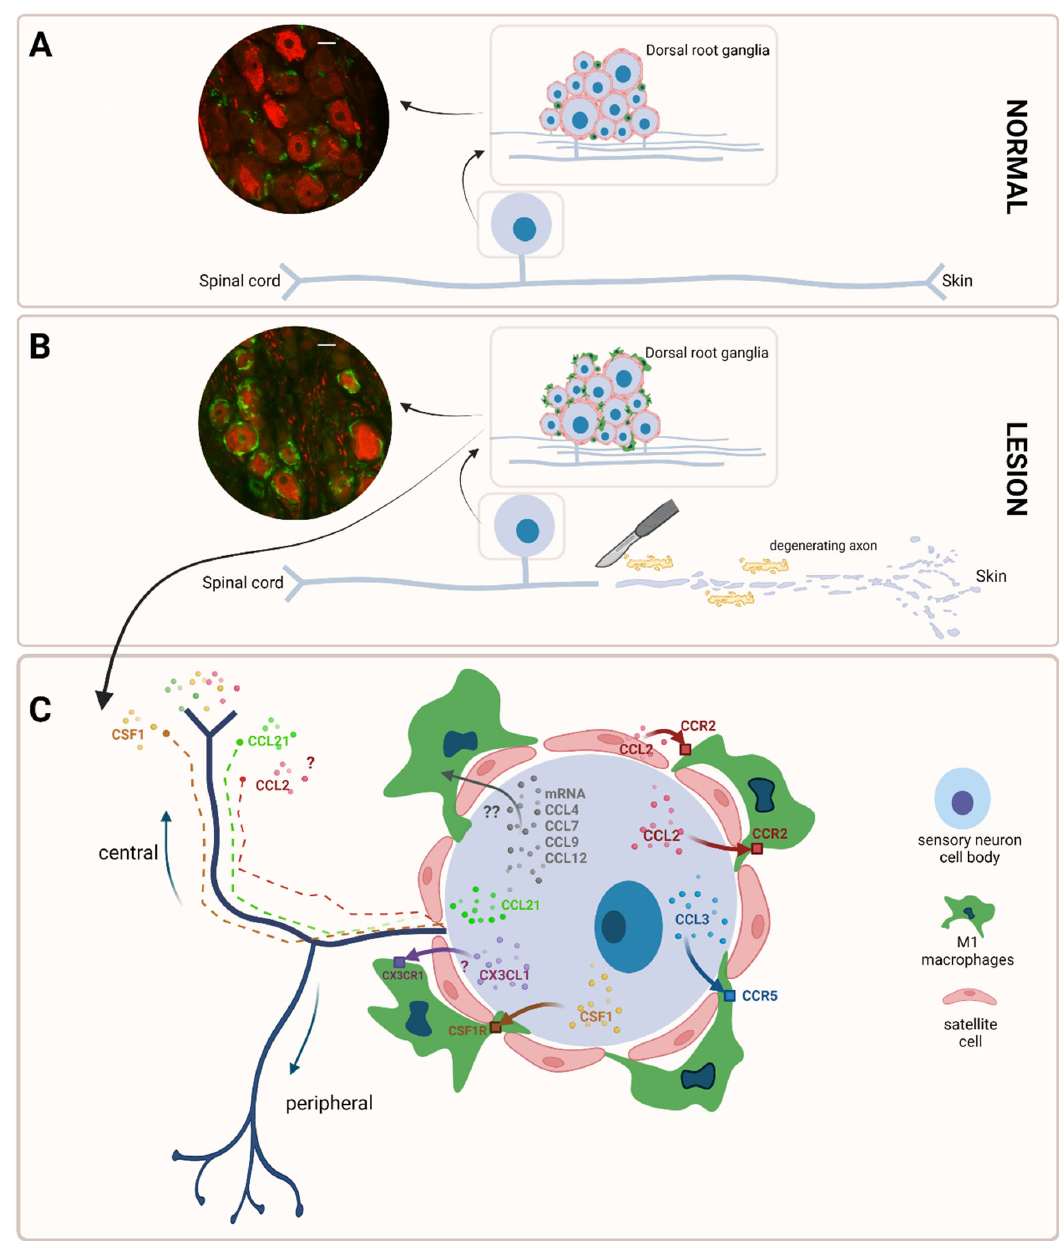
Figure 3. After a peripheral nerve lesion, macrophages are attracted around the DRG neurons. ( A ) Graphic representation of a normal DRG, with few macrophages scattered between DRG neurons. To the left, DRG immunostaining showing a small number of Iba1 (+) macrophages (green) scattered among large NF200 (+) neurons (red). Scale bar—20 μ m. ( B ) Graphic representation of the DRG after the peripheral nerve lesion, with numerous endoneurial and hematogenous macrophages attracted around neurons. To the left, DRG immunostaining showing an increased number of Iba1 (+) macrophages (green) around large NF200 (+) neurons (red). Scale bar—20 μ m. ( C ) Signaling pathways that attract macrophages around DRG neurons. CCL2, CSF1, and CCL3 are experimentally proven to contribute to clustering of macrophages around DRG neurons. For CX3CL1, CCL4, CCL7, CCL9, and CCL12, more experimental data are required to confirm their chemoattractant effects. CCL2, CSF1 and CCL21 may also act as secondary mediators at the spinal cord level. Legend : DRG—dorsal root ganglia; Iba1—ionized calcium ‐ binding adaptor molecule 1; NF200—neurofilament 200; CCL2, ‐ 3, ‐ 4, ‐ 7, ‐ 9, ‐ 12, ‐ 21—chemokine (C ‐ C motif) ligand 2, ‐ 3, ‐ 4, ‐ 7, ‐ 9, ‐ 12, ‐ 21; CX3CL1—chemokine (C ‐ X3 ‐ C motif) ligand 1; CSF1—colony ‐ stimulating factor 1.